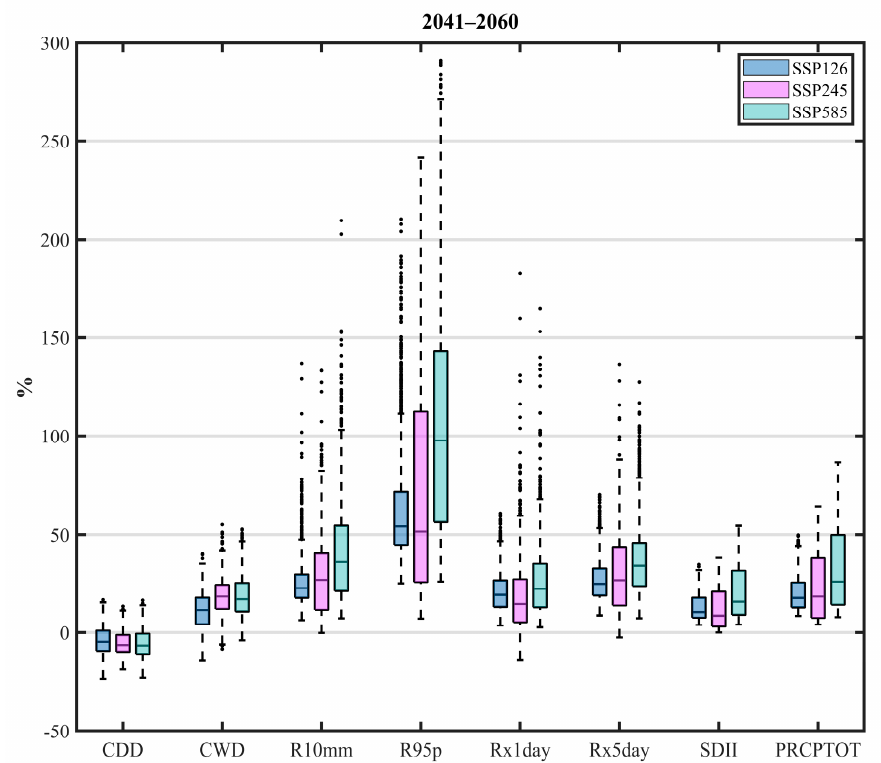
Figure 7. Box-and-whisker plots for the projected changes (expressed as percentages) of eight extreme precipitation indices in the period 2041–2060 as compared to the base period under three SSPs over the Qilian Mountains. The upper and lower edges of each box represent the 75th and 25th percentile values, respectively, while the line in each box shows the median of the distribution. The upper and lower whiskers represent the upper and lower limits of the normal range, respectively. Note that the future change is represented by the ensemble of three corrected CMIP6 models. Table 5. Average changes of the eight extreme precipitation indices over the Qilian Mountains under different SSPs. The first two columns under each emission scenario are the changes in the middle and end of the 21st century as compared to the base period. The third column under each emission scenario is the change at the end of the twenty-first century as compared to the middle of the twenty-first